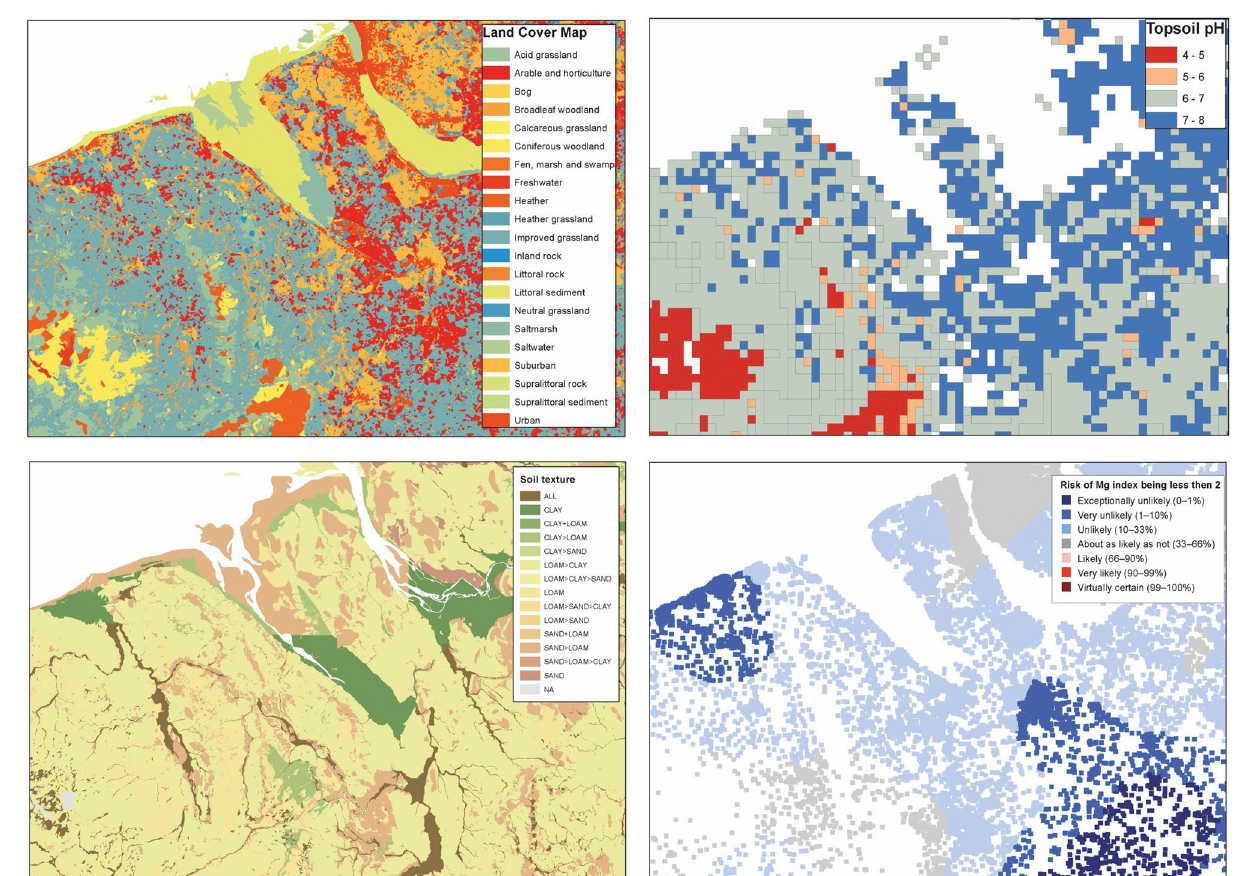
Figure 6. examples of input datasets to define areas of potential lime demand, all available on UKSO.org. Clockwise from top left: land use 33 , pH 43 , risk of Mg deficiency 6 , soil parent material Model soil texture 45 . The top two excerpts are based on digital spatial data licensed from the UK Centre for Ecology and Hydrology. Created using ArcMap 10.7.1, ESRI,